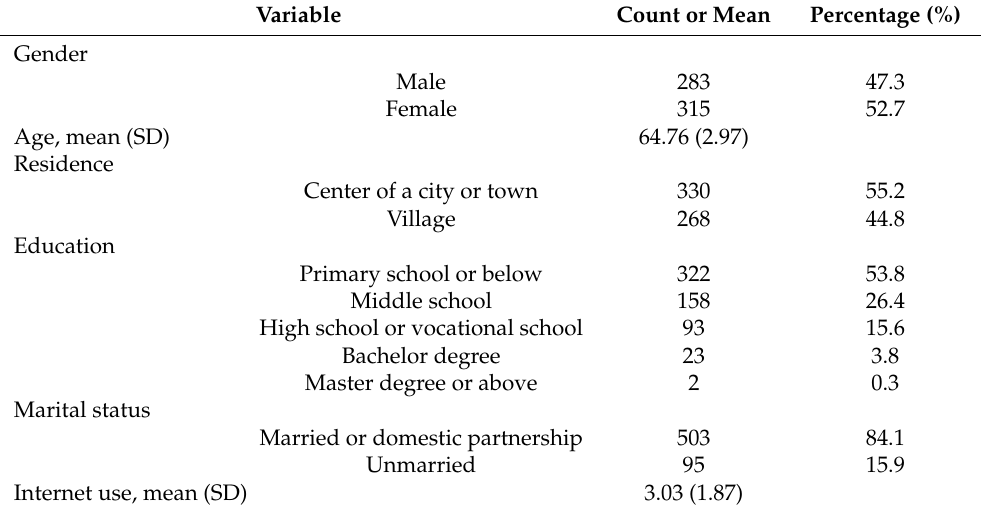
Table 1. Descriptions of the study participants in Sample 1 (N =